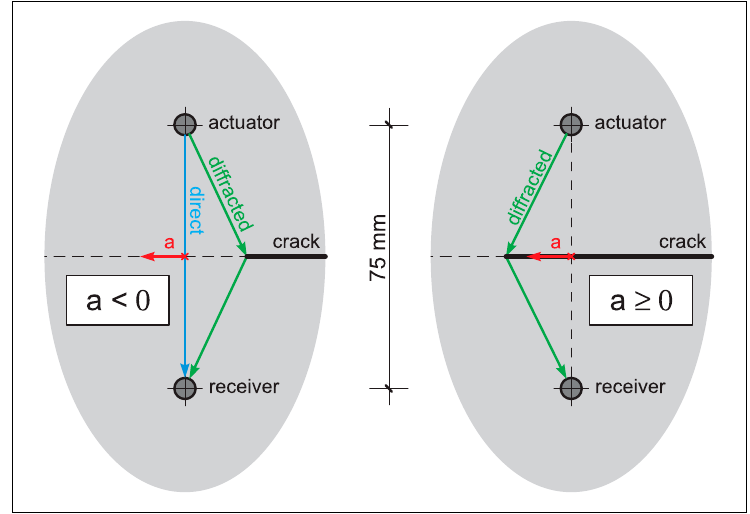
Figure 12. Wave propagation model near the crack tip—short (direct) and long (diffracted) wave propagation paths—for two different crack lengths, illustrating how the amplitude of the response wave is affected by diffraction.